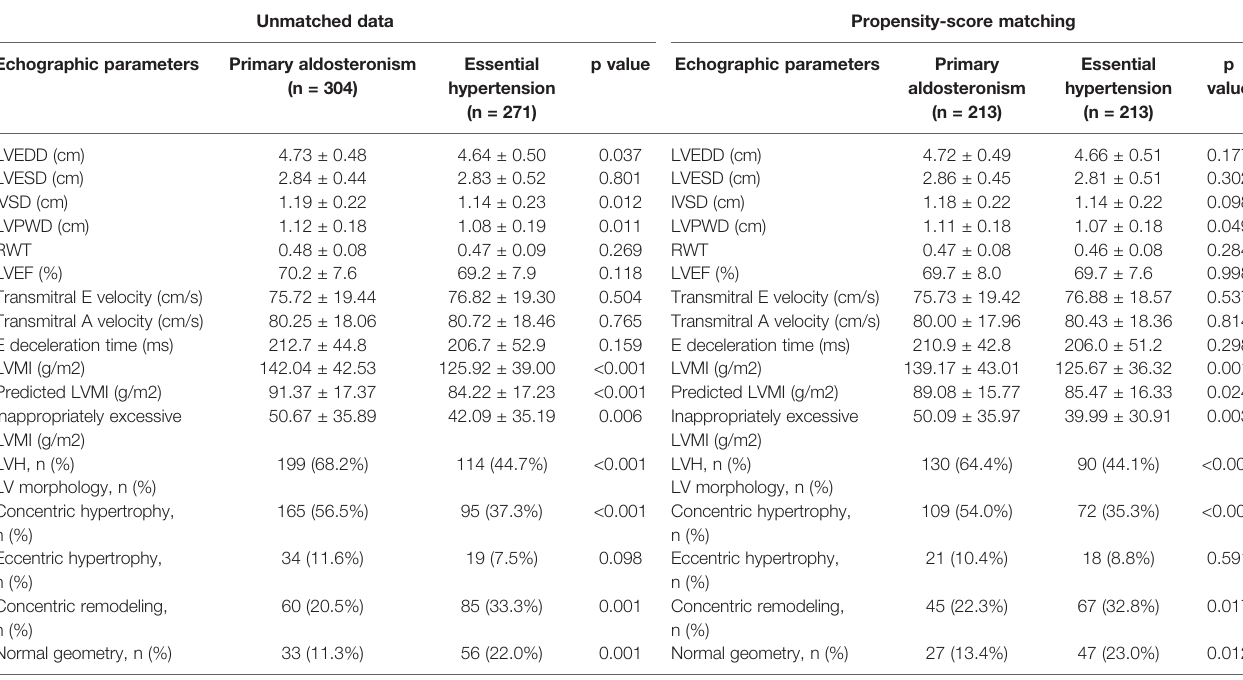
TABLE 2 | Echocardiographic features and Doppler-derived indexes of patients with primary aldosteronism and essential